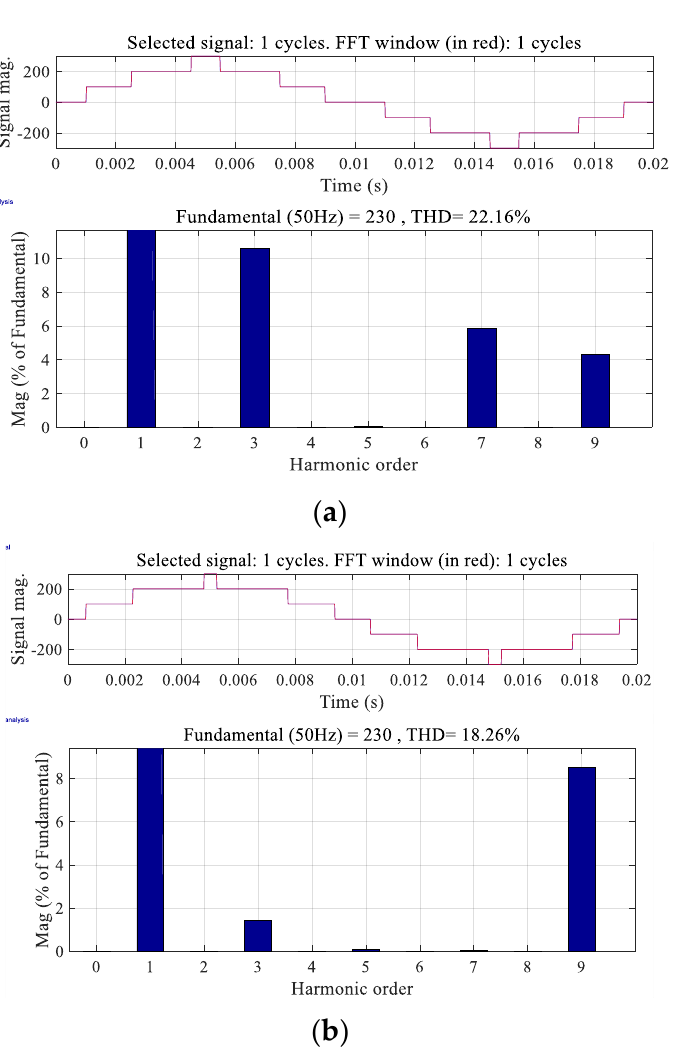
Figure 8. Curve showing variation between the Voltage THD in percent and modulation index for SHE of 5th order harmonics and for the proposed technique.